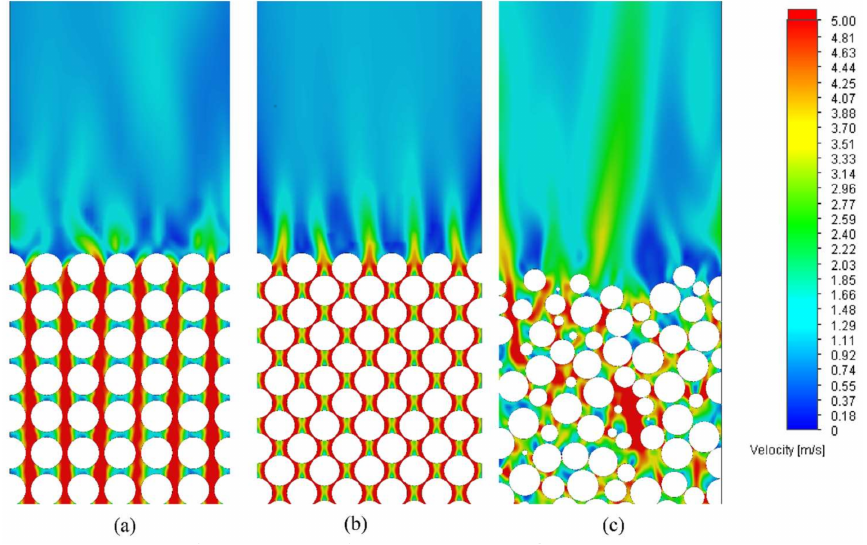
Figure 13. Velocity distribution from front plane cut plot ( a ) BCC; ( b ) FCC; ( c )